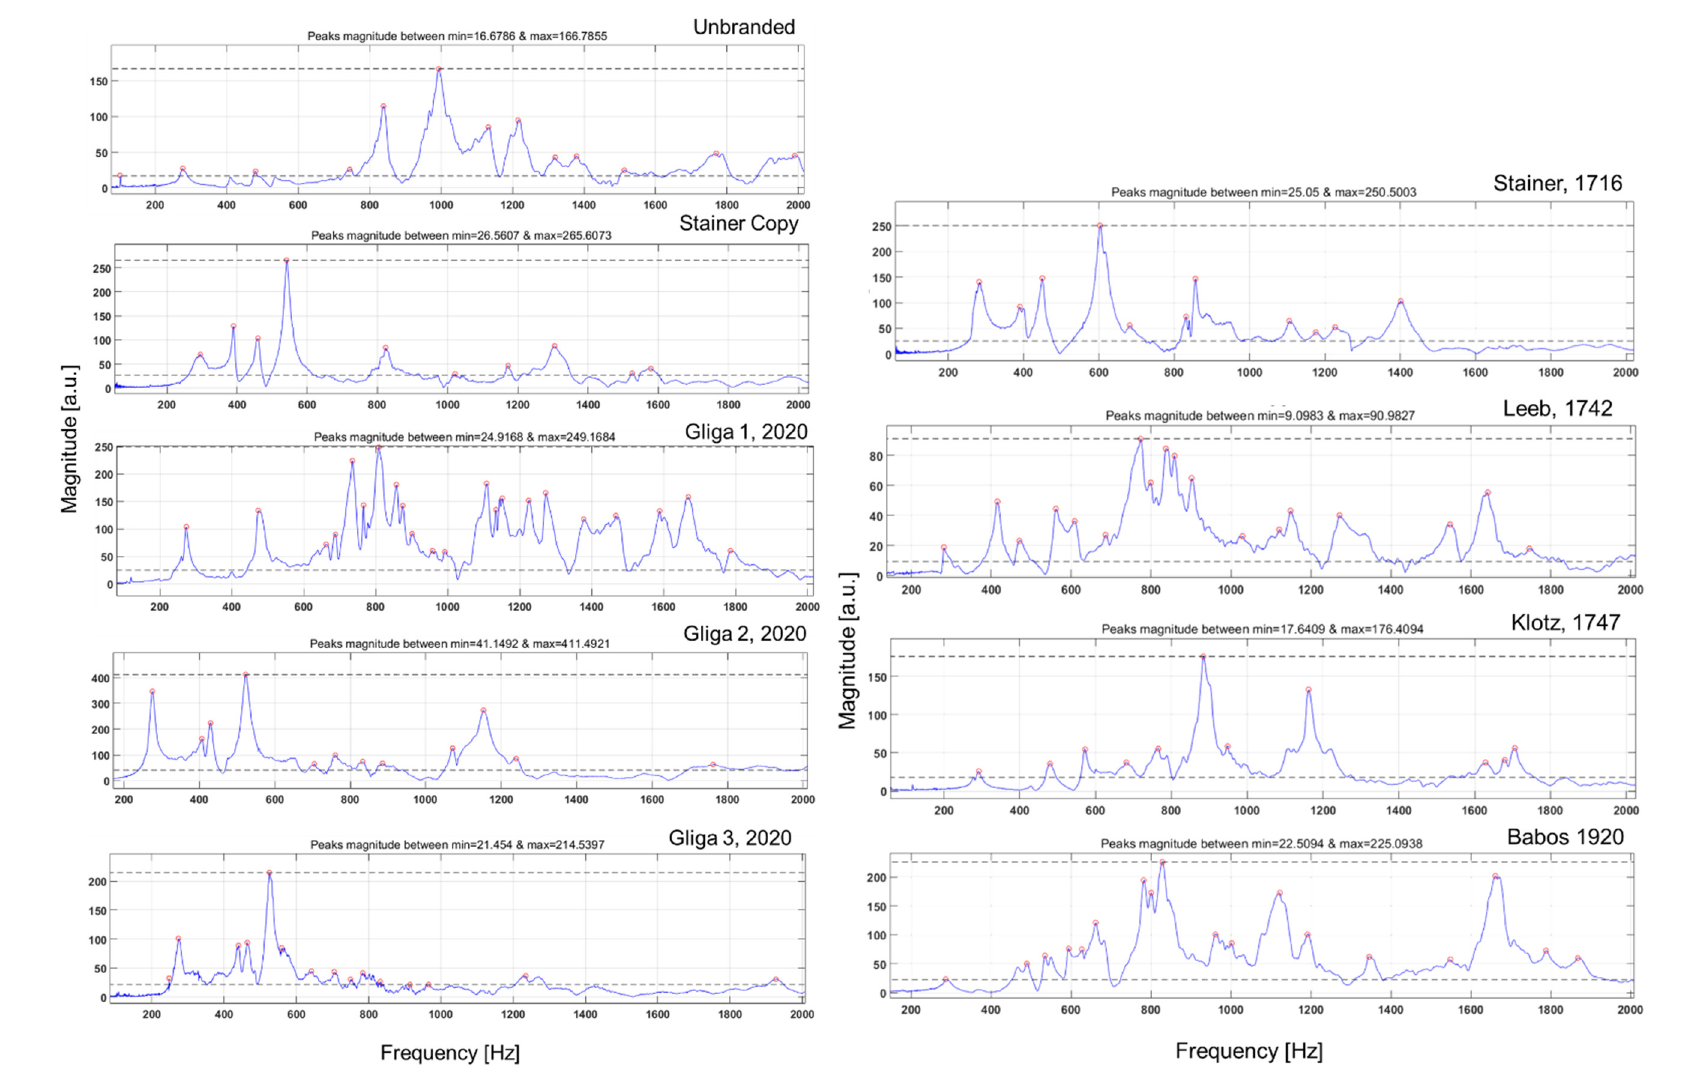
Figure 8. The frequency spectrum plots for the dynamic analysis.